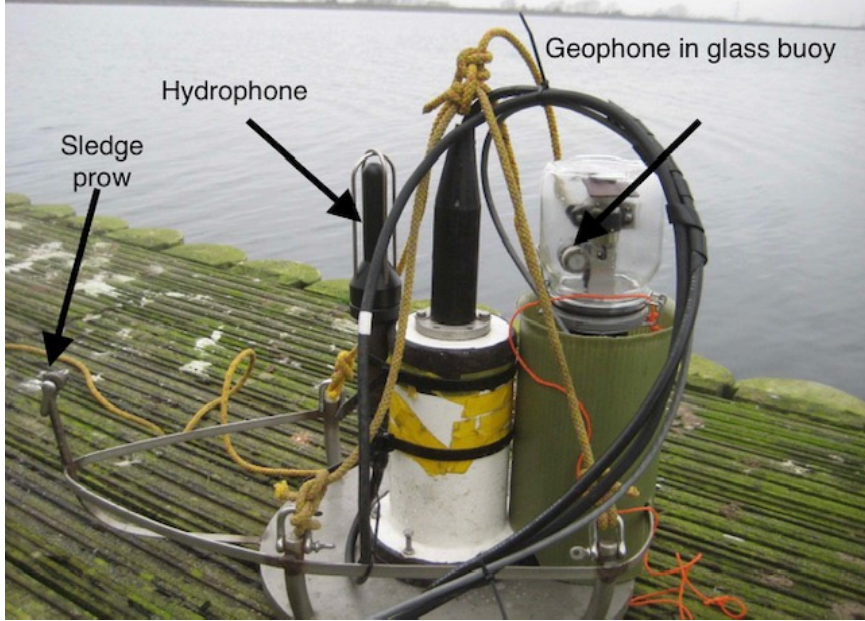
Figure 14. The test rig ready for deployment at Wraysbury in March